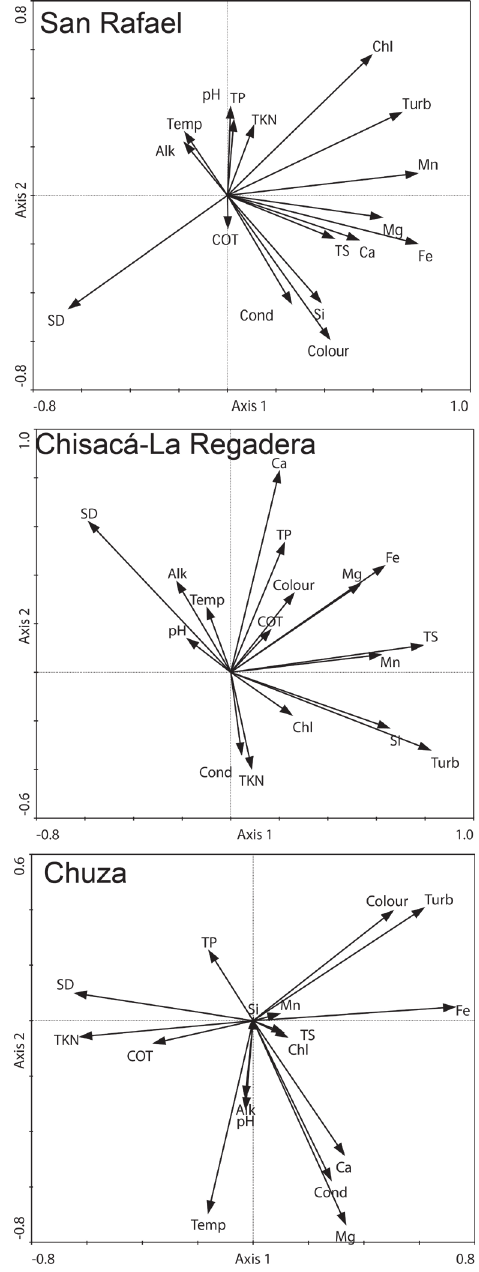
Figure 3. Biplot of the principal component analysis of physical and chemical variables of each studied